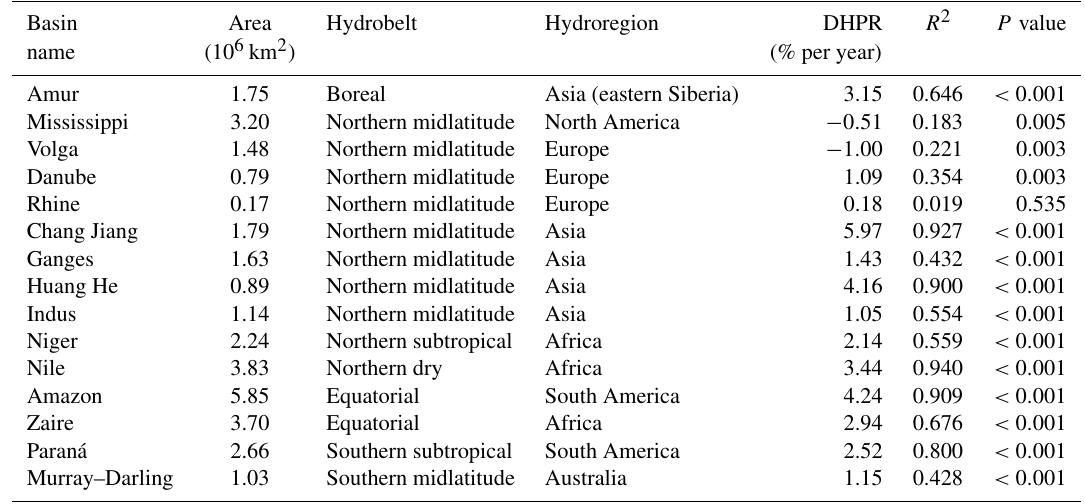
Table 1. Estimates of the Differential Human Pressure on Rivers index, DHPR, for 15 major river basins. Basin name, contributing